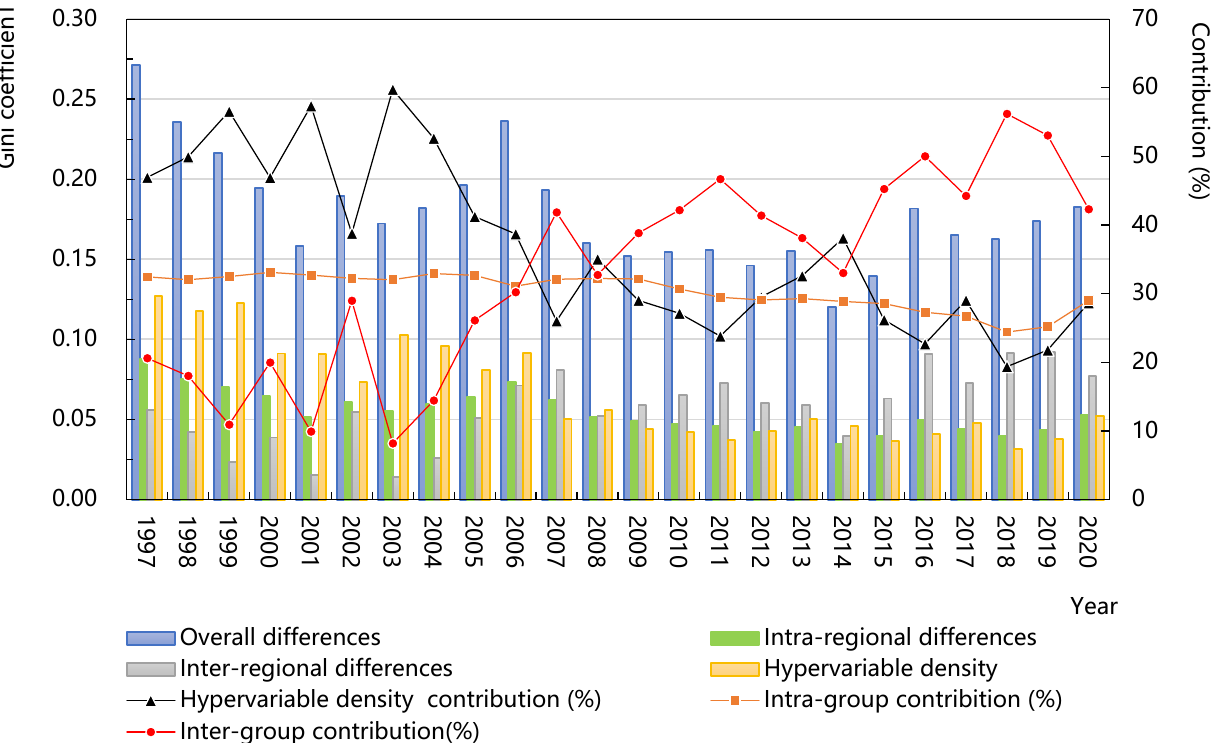
Figure 5. Decomposition of and contribution of the gap between the eastern, central and the western regions.